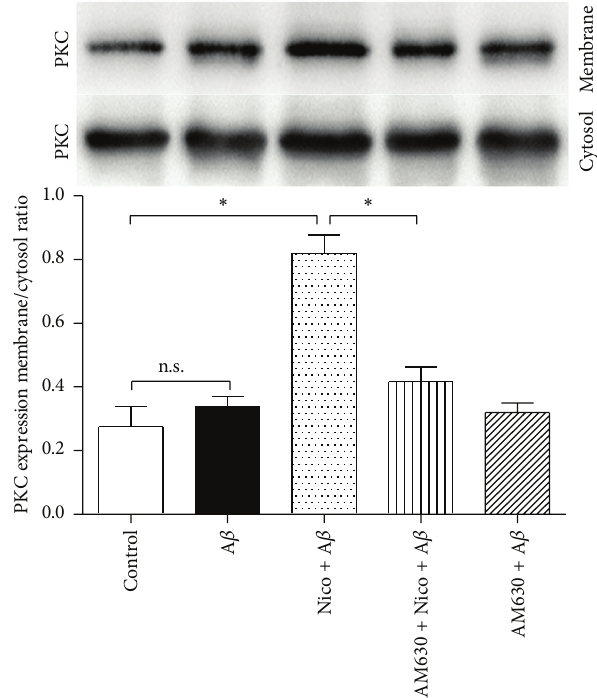
Figure5:CB2receptorantagonistabolishednicotine-inducedeffect on PKC expression. The microglial cells were divided into five groups: control: cells cultured in drug-free medium; A 𝛽 : cells cultured in the medium containing 5 𝜇 M A 𝛽 ; nicotine (Nico) + A 𝛽 : cells cultured in the medium containing 10 𝜇 M nicotine and 5 𝜇 M A 𝛽 ; AM630 + Nico + A 𝛽 : cells cultured in the medium containing 10 𝜇 M CB2 antagonist AM630, 10 𝜇 M nicotine, and 5 𝜇 M A 𝛽 ; AM630 + A 𝛽 : cells cultured in the medium containing 10 𝜇 M AM630 and 5 𝜇 M A 𝛽 . After an incubation of 24 h, western blot was used to detect PKC expression ( 𝑛 = 4 ). Results are expressed as means ± SD, ∗ 𝑃 < 0.05 ; n.s.: no